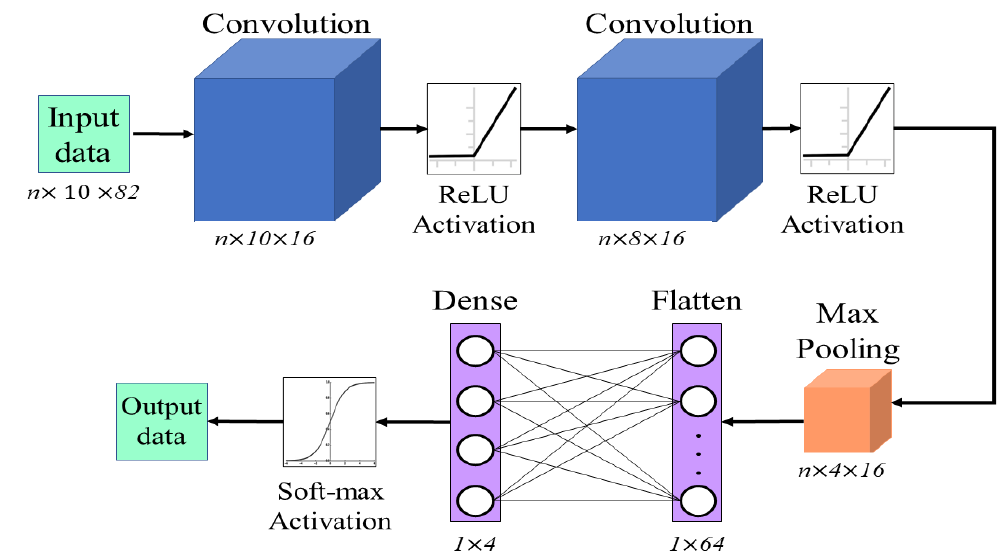
Figure 8. The architecture of the CNN network implemented for the classification process, where n is the size of the input data